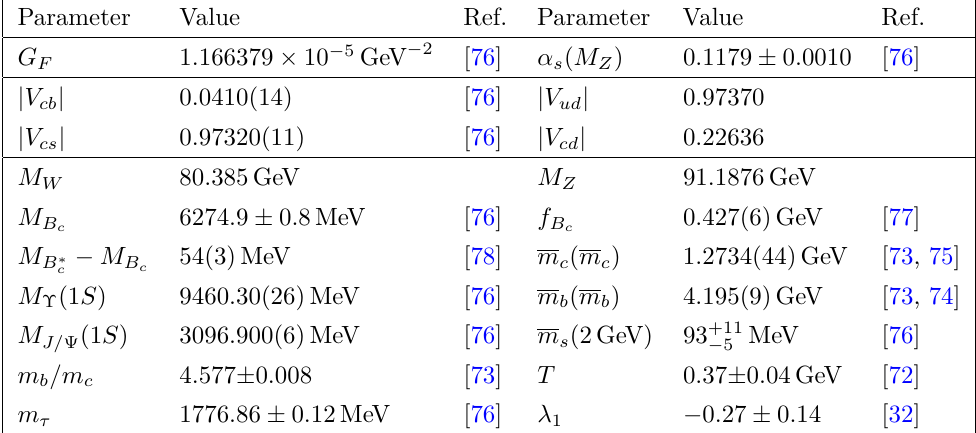
Table 2 . Input parameters used for the numerical